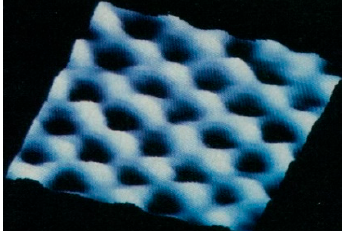
Figure 3. Crystal lattice of Muscovite mica imaged by atomic force microscopy (AFM), showing locations of recessed hydroxyl (OH) and ionized hydroxyl (O − ) groups, as depressions (dark spots) on the mica surface. Image size is 2.6 nm × 2.6 nm. Modified from [58].